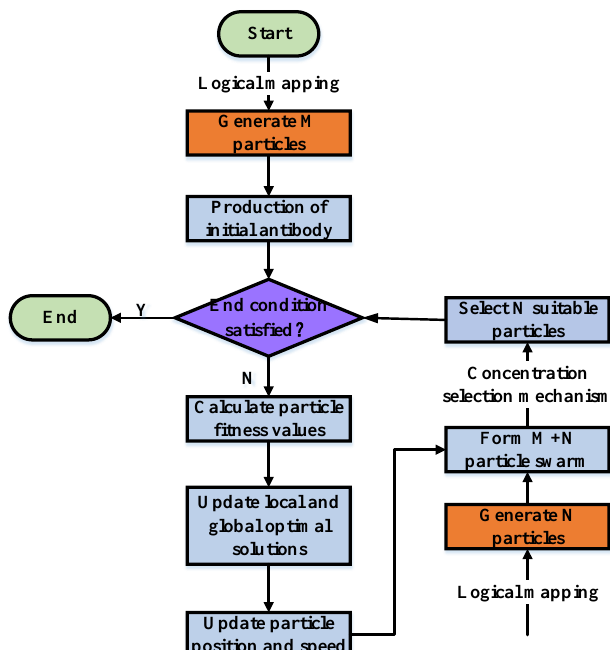
Figure 5. The flow chart of Immune based PSO.